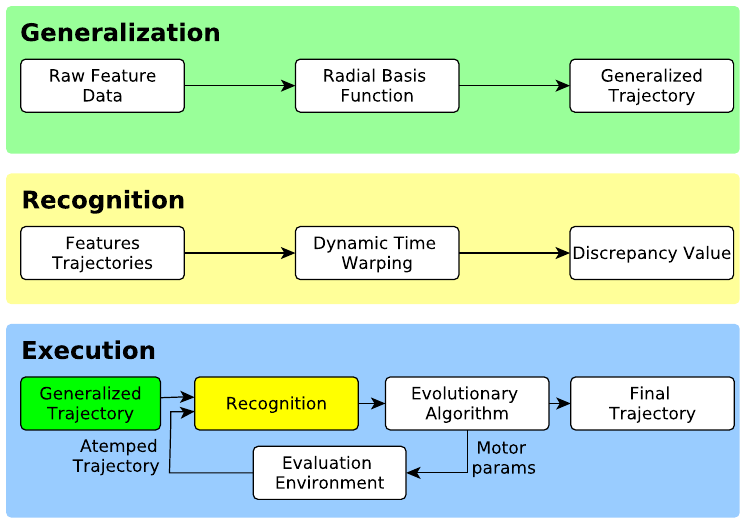
Figure 1. Continuous Goal-Directed Actions (CGDA) framework